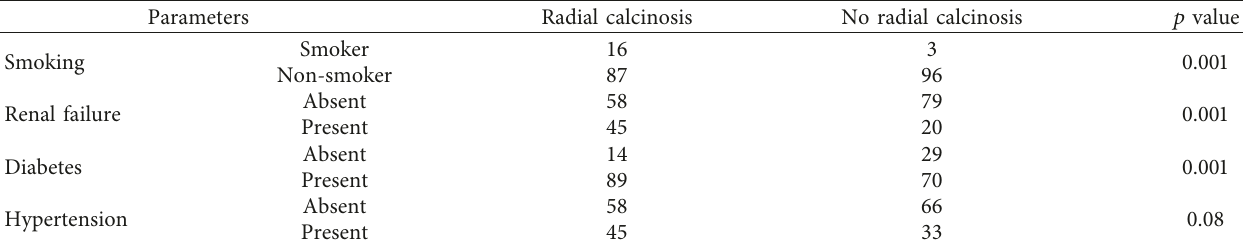
Table 3: Unadjusted analysis of the risk factors involved in the presence of radial calcinosis.